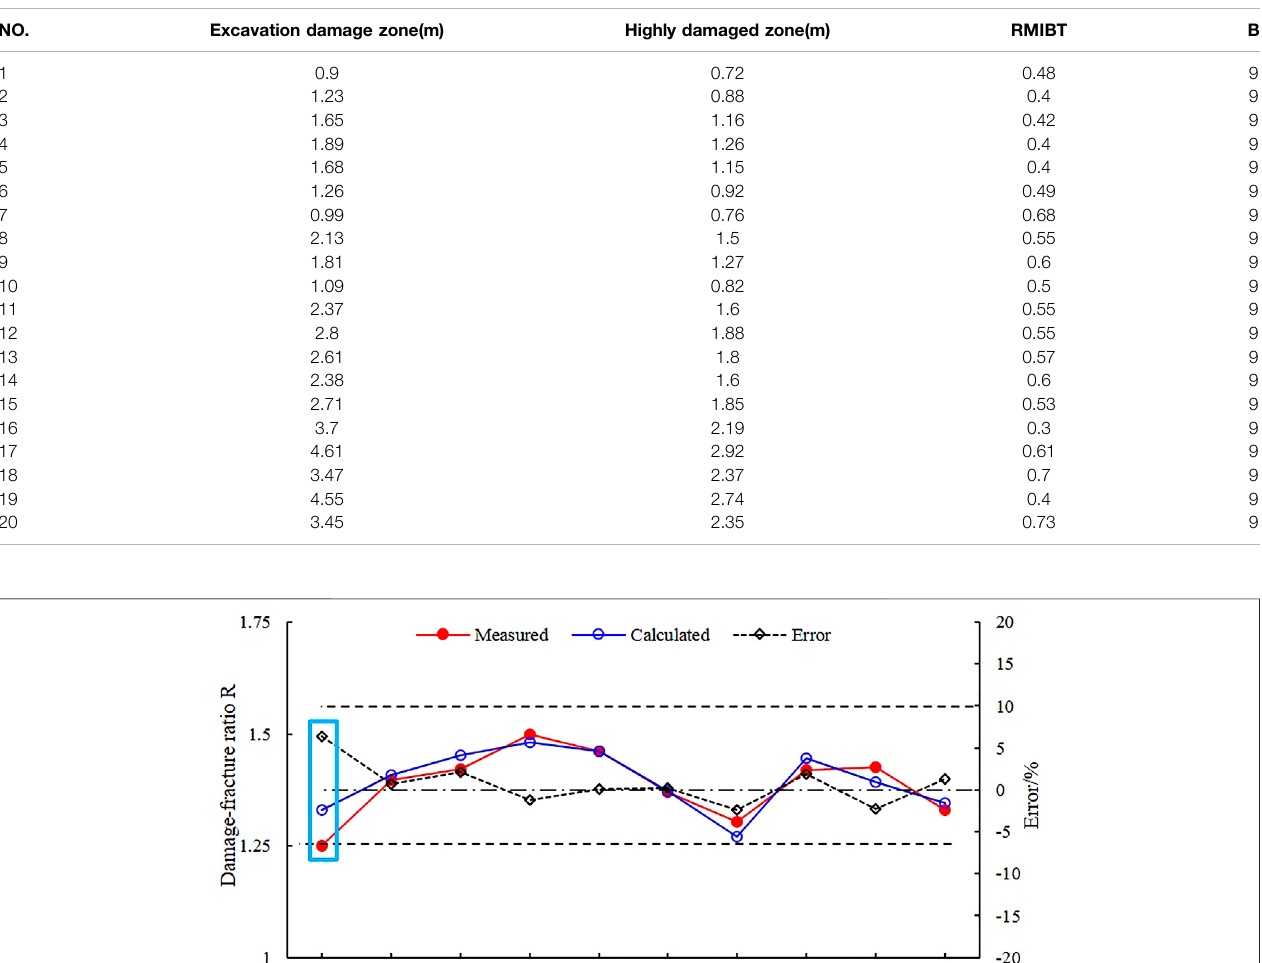
TABLE 1 | Test data in Baihetan engineering practice. NO.